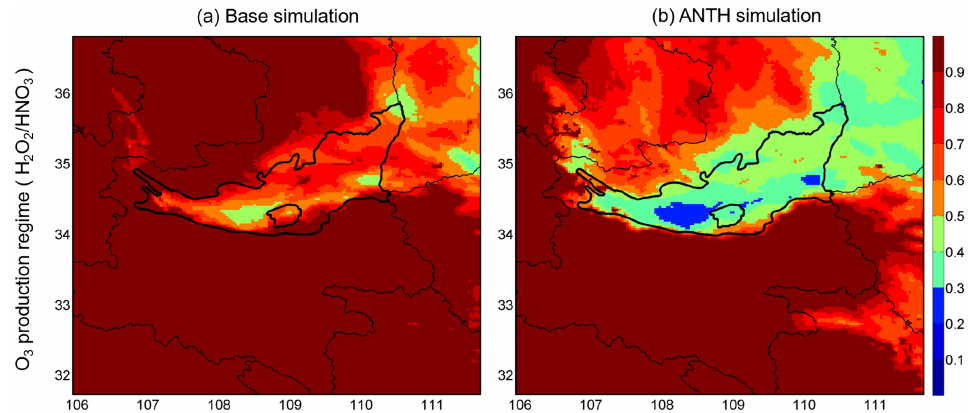
Figure 10. The monthly mean ratio of H 2 O 2 / HNO 3 during the daily O 3 peak time (14:00–18:00LT) in August 2011 in the (a) base simulation and (b) the simulation without biogenic sources.